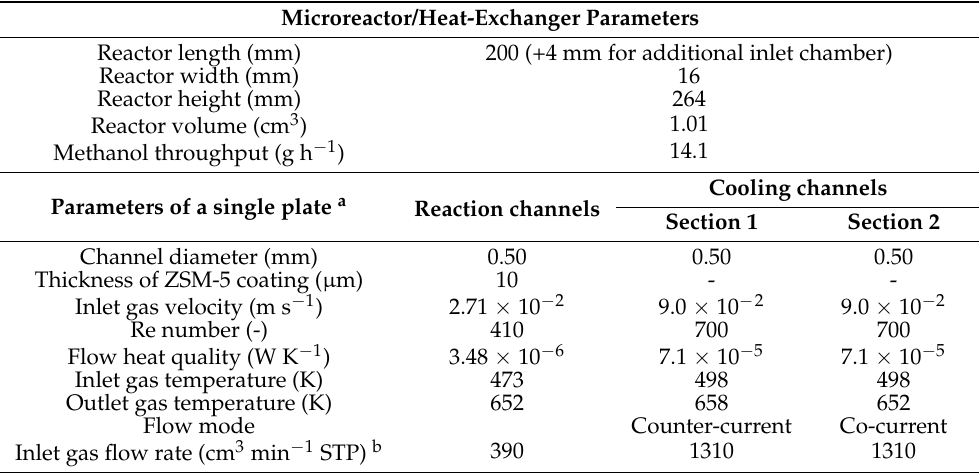
Table 2. Parameters of the microreactor/heat-exchanger geometry and inlet